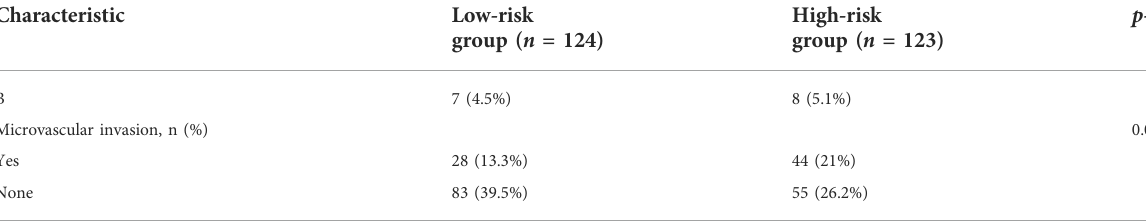
TABLE 2 ( Continued ) Associations between the signature and patients ’ characteristics in the training cohort.